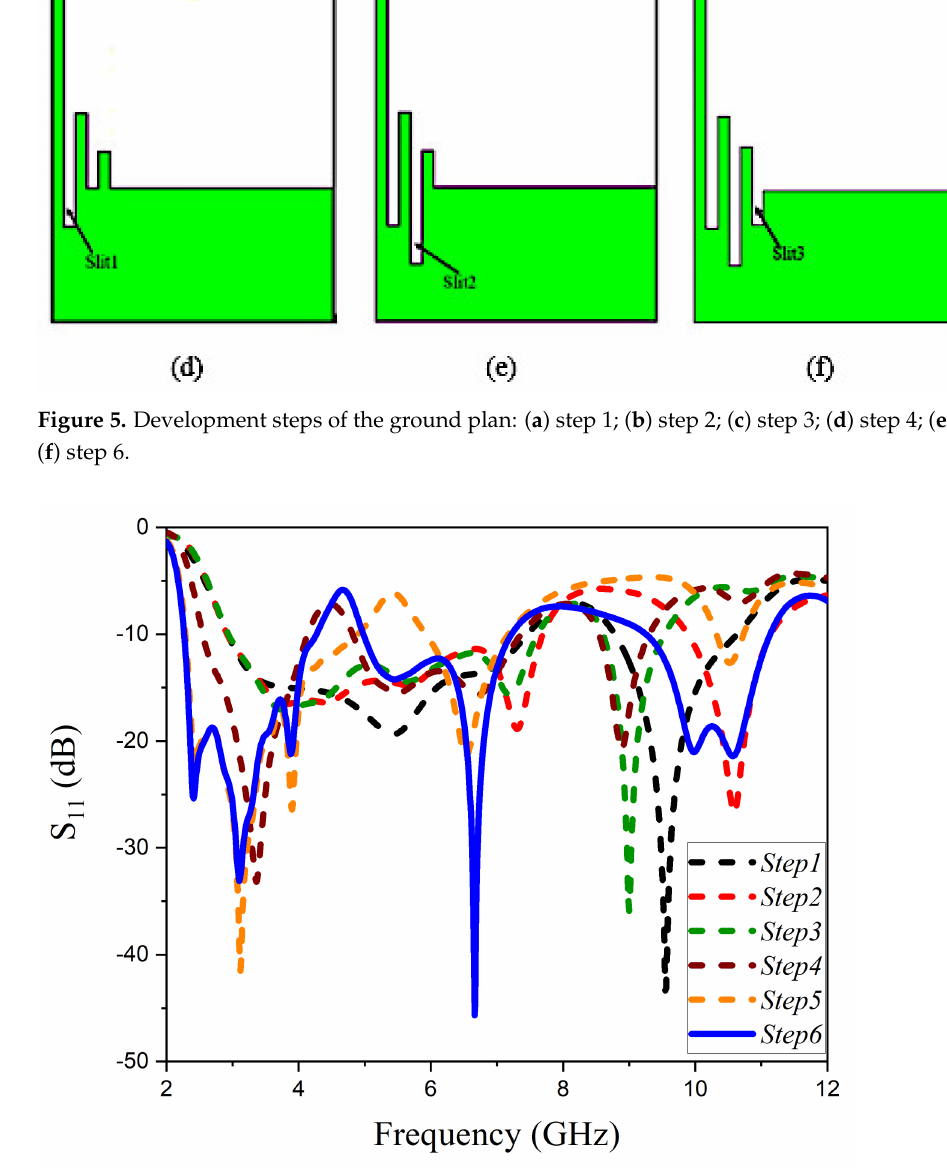
Figure 6. Simulated reflection coefficient for each development step of the modified ground